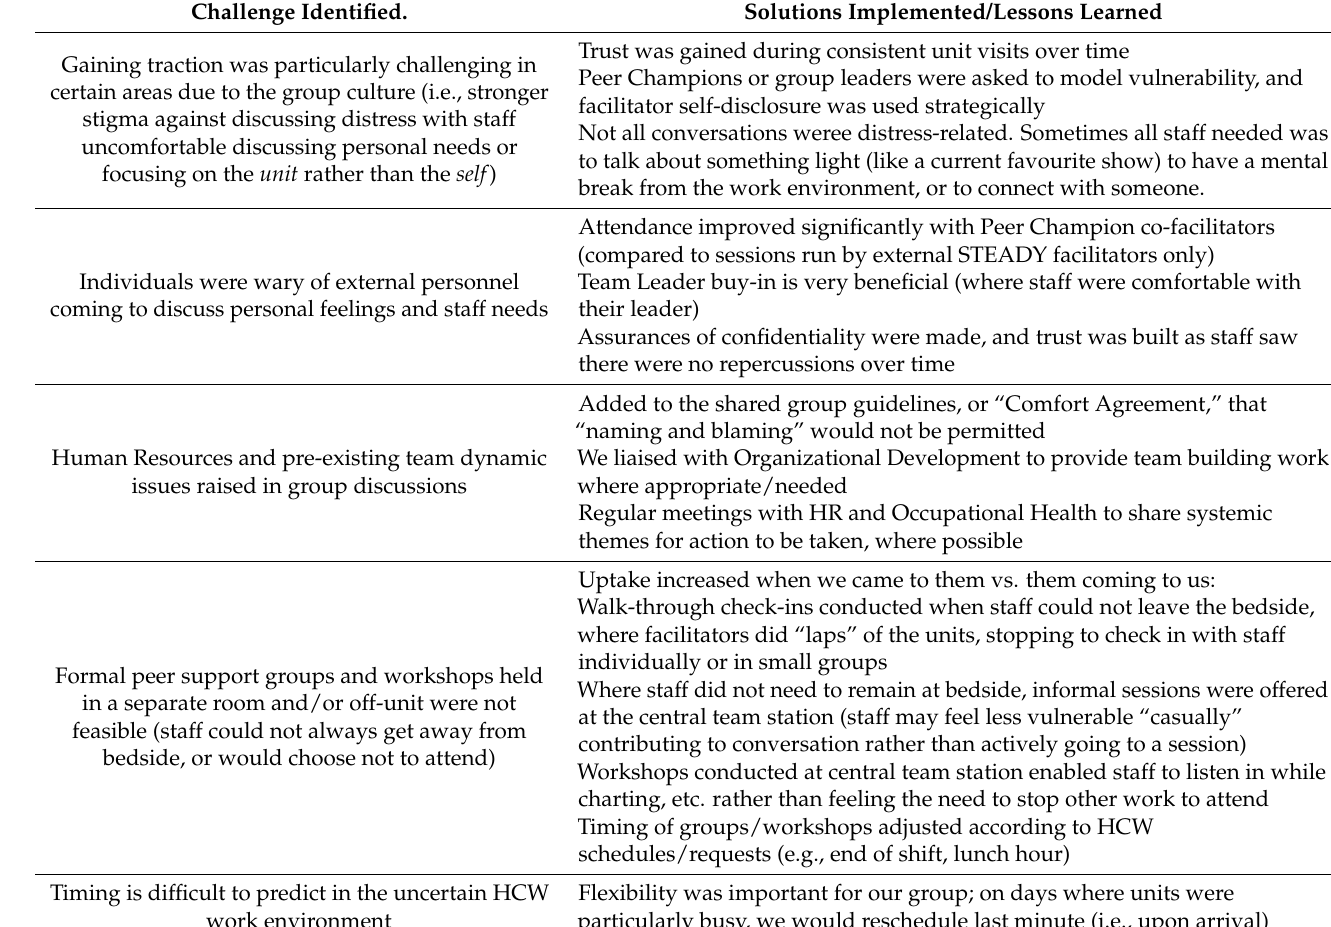
Table 3. Lessons learned throughout STEADY Implementation: Challenges faced (in some or all target groups) and solutions